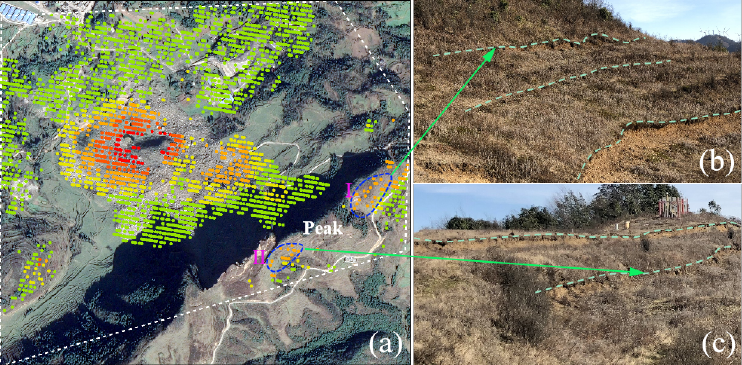
Figure 7. Comparison between DS-InSAR results with field investigation results: ( a ) DS-InSAR time series monitoring results; ( b ) Investigation area I ; ( c ) Investigation area II .